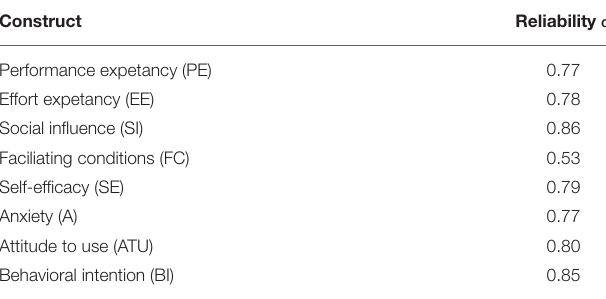
TABLE 3 | Reliability of the